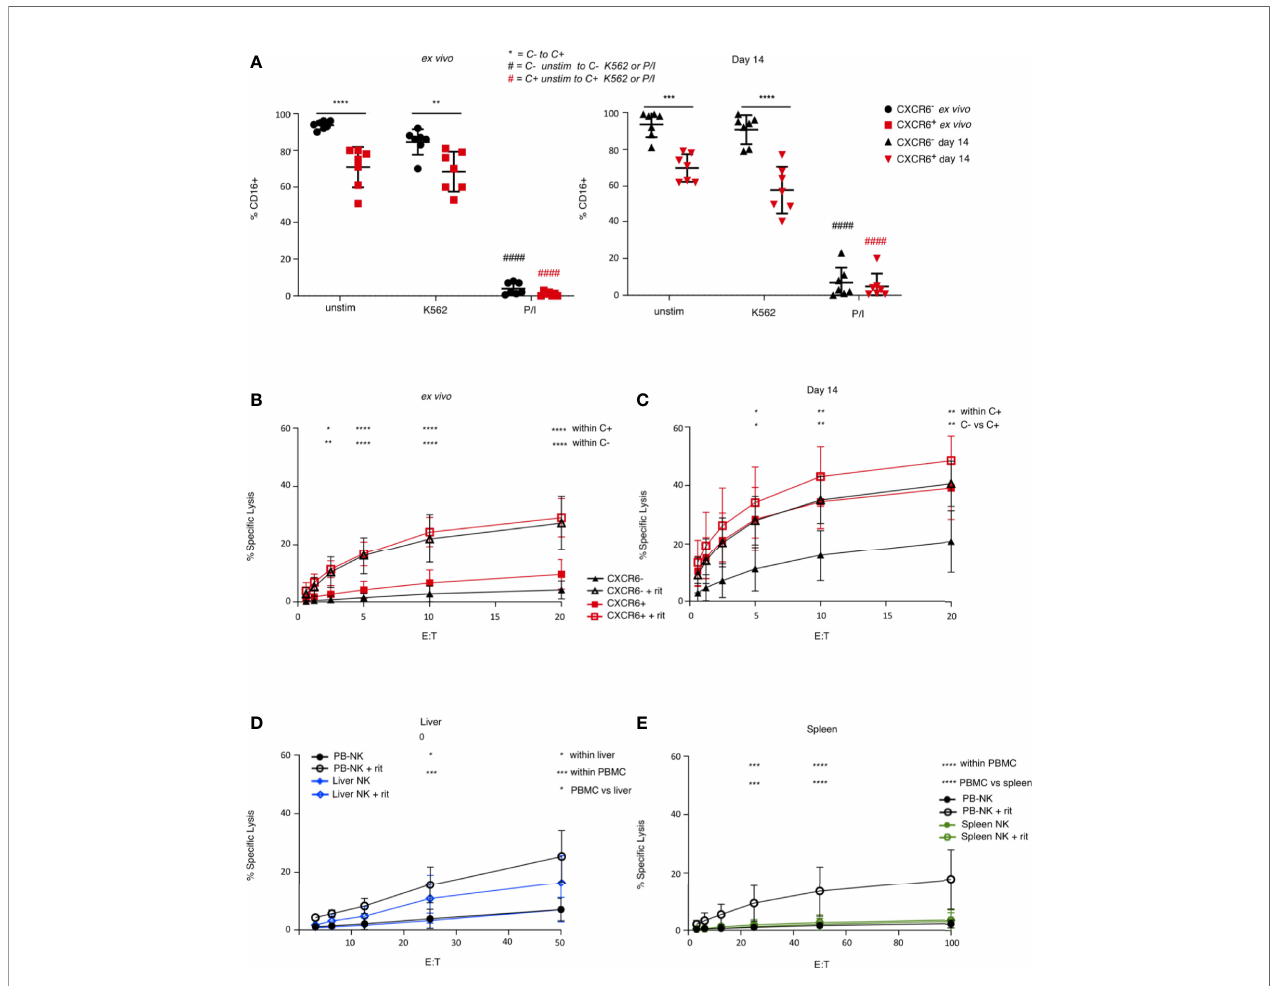
FIGURE 6 | Comparison of ADCC function in ex vivo , day 14-cultured, liver, and spleen NK cells. (A) CXCR6 + NK cells express less CD16 than CXCR6 - NK cells, and down-regulate CD16 in response to K562 target cells after 14 days in culture, although not signi fi cantly ( n=7 ). A two-way ANOVA with Tukey ’ s multiple comparisons test was performed. (B) Ex vivo CXCR6- and + NK cells have equal capacity to perform ADCC ( n=5 ). Freshly sorted or 14 day-cultured CXCR6 + and CXCR6 – PB-NK cells or bulk liver or spleen cells were incubated with Raji targets with or without rituximab (rit). NK cell percentages in bulk liver and spleen cells were as described in the legend to Figure 5 . Assays were performed in duplicate or triplicate. (C) 14 day-cultured CXCR6 + NK cells exhibit enhanced ADCC function compared to CXCR6 - NK cells ( n=5 ). (D) Unsorted liver and PB-NK cells have comparable ADCC activity ( n=5 ). (E) Unsorted spleen NK cells have decreased ADCC compared to PB and liver NK cells ( n=8 ). A two-way ANOVA with Tukey ’ s multiple comparisons test was performed. p values for statistically signi fi cant relationships are shown. For complete statistical analysis, see Supplementary Table 8 . (*p < 0.05, **p < 0.01, ***p < 0.001, ****p <